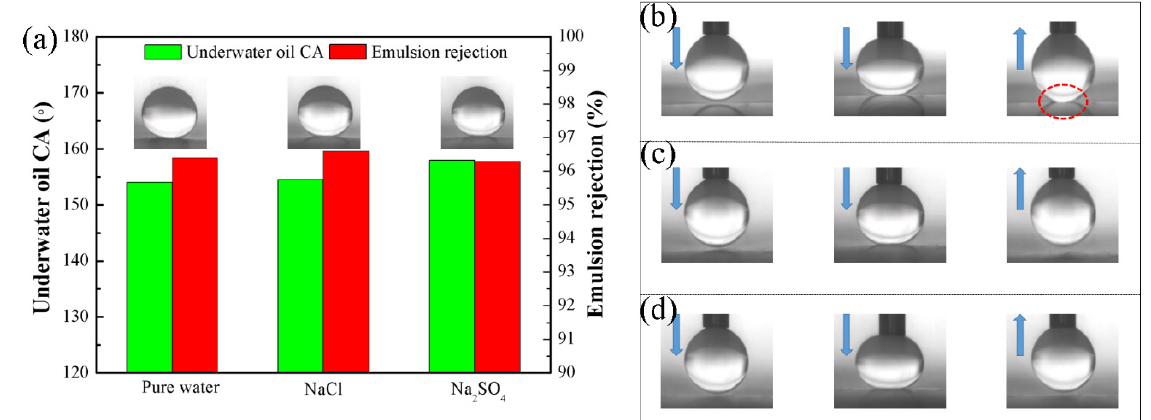
Figure 4. ( a ) Underwater oil CA and emulsion rejection rate of M3 membrane after washing in different solutions, ( b ) Dynamic underwater oil adhesion test of M3 membrane after washing in pure water, ( c ) Dynamic underwater oil adhesion test of M3 membrane after washing in NaCl solution, ( d ) Dynamic underwater oil adhesion test of M3 membrane after washing in Na 2 SO 4 solution.